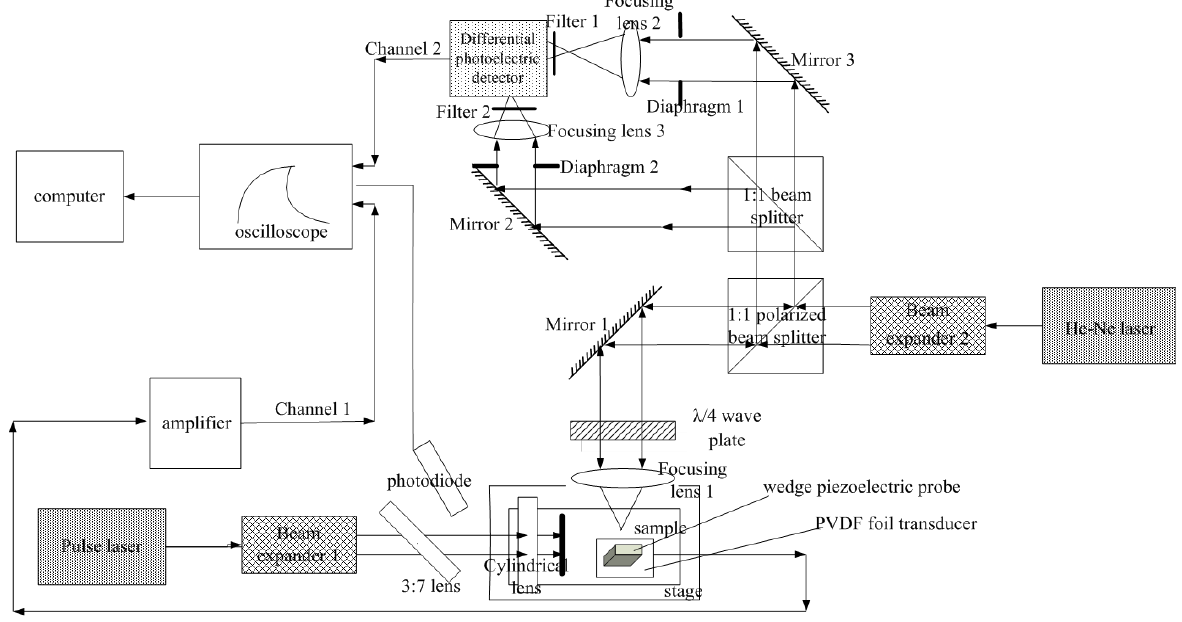
Figure 4. Laser beam path of the integrated laser-induced PZT/DC SAW